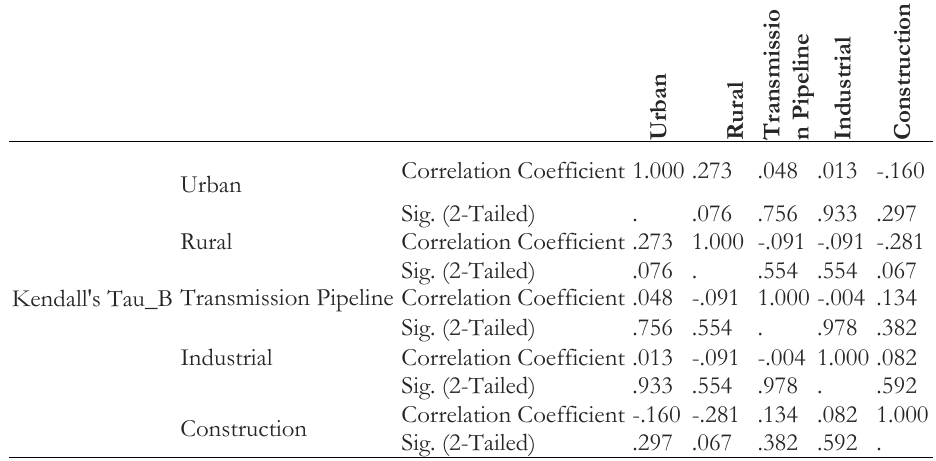
Table 3. Kendall's Tau_b correlation test for categorizing of projects.